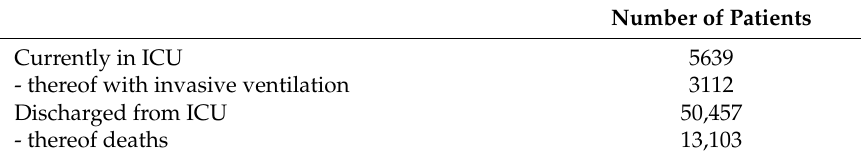
Table 2. Inpatient treatment. (https: // www.rki.de / DE / Content / InfAZ / N / Neuartiges_Coronavirus / Situationsberichte / Dez_2020 / 2020-12-31-en.pdf?__blob = publication (File accessed on 31 December 20,